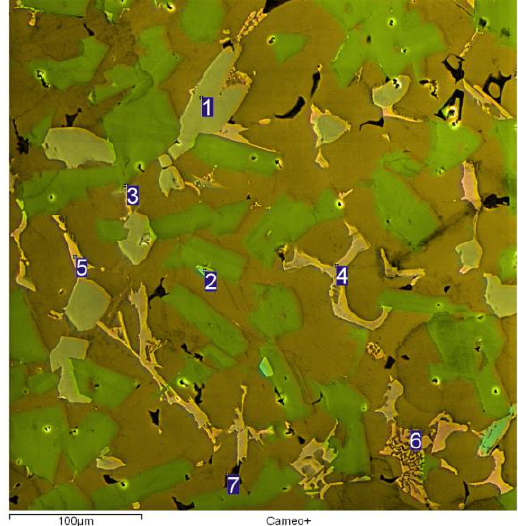
Figure 5. Microstructure of hypereutectic aluminum-silicon alloy with the characteristic microstructural components of various chemical composition, SEM, secondary electrons (SE).